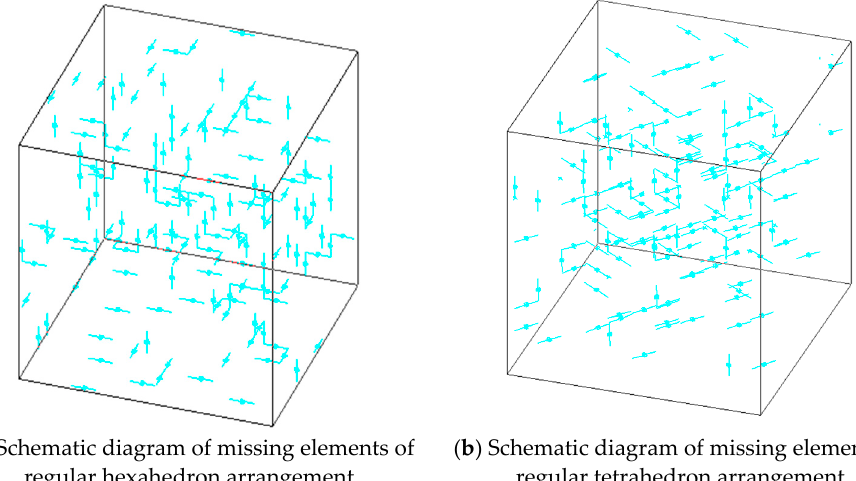
Figure 12. Schematic diagram of missing elements for 3D-RBSN model.